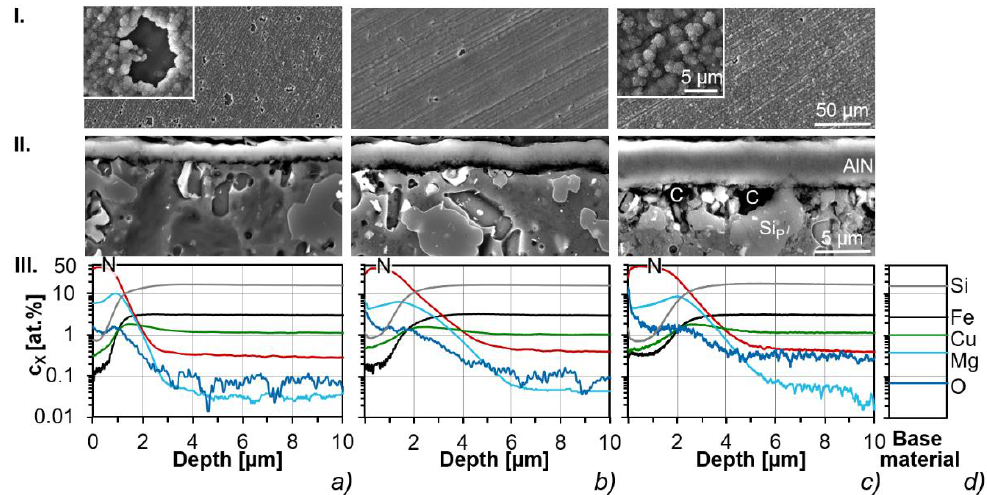
Figure 2. Characterization of AlN layers with different thicknesses t AlN (effective nitriding times): ( a ) t AlN = 1.5 µm; ( b ) t AlN = 3 µm; ( c ) t AlN = 4.3 µm; ( d ) Al base material by means of I. surface topography; II. cross sections (C… cavities; Si P … primary silicon) and III. element concentration-depth profiles measured by GDOES (without illustration of Al content).